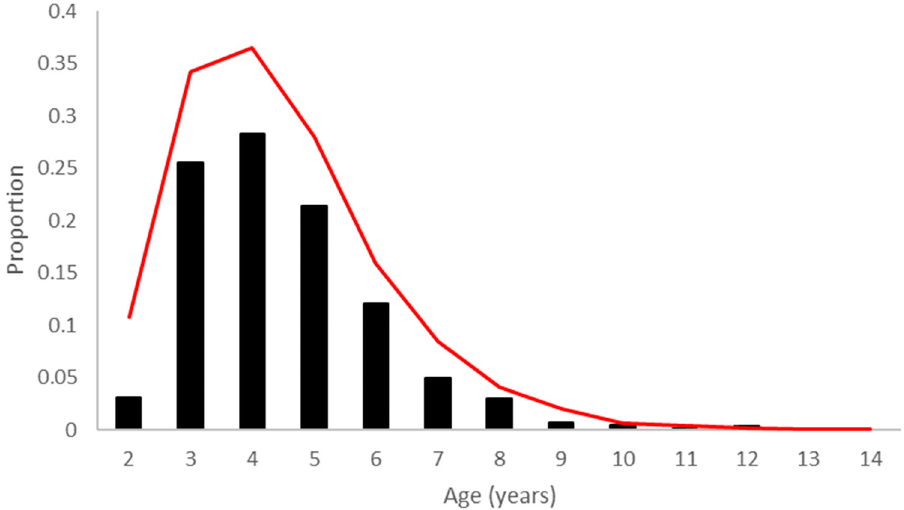
Figure 1. Proportion of participants (red) and the proportion of poor performance reports (black) in each age group.